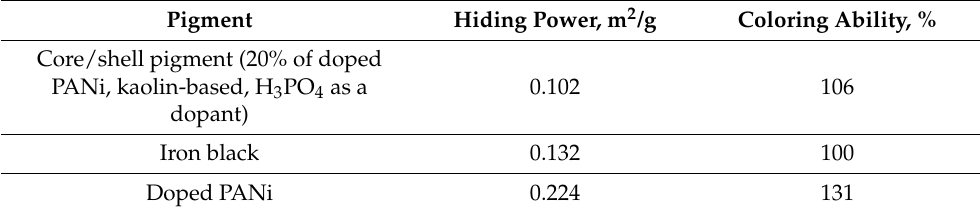
Table 2. Black pigments comparison.